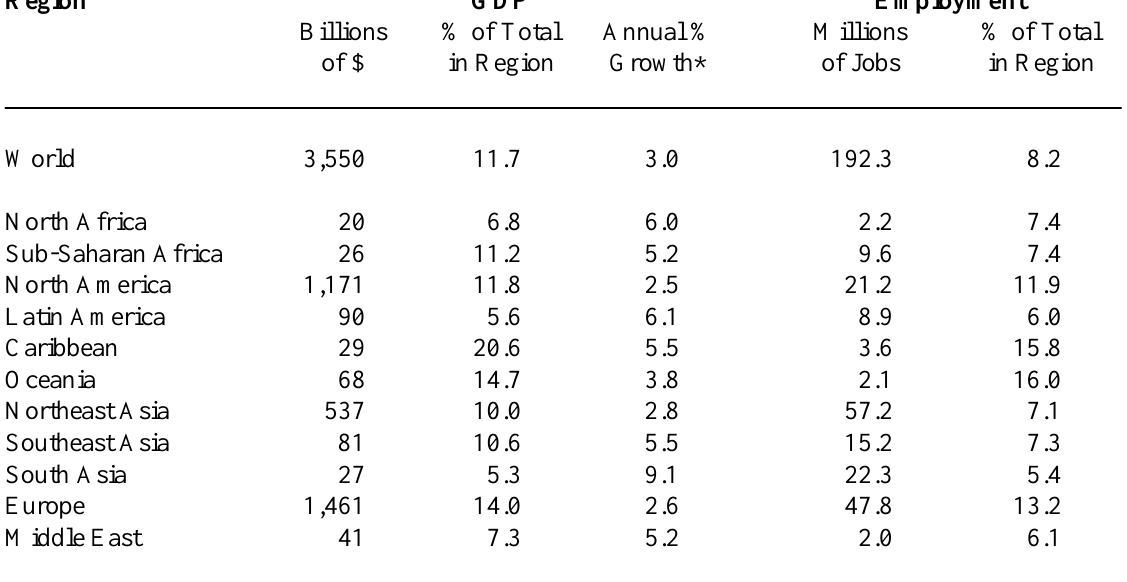
Table 1: WTTC Economic Impact Estimates for Travel and Tourism (1999) Region GDP Employment Billions % of Total Annual % Millions % of Total of $ in Region Growth* of Jobs in